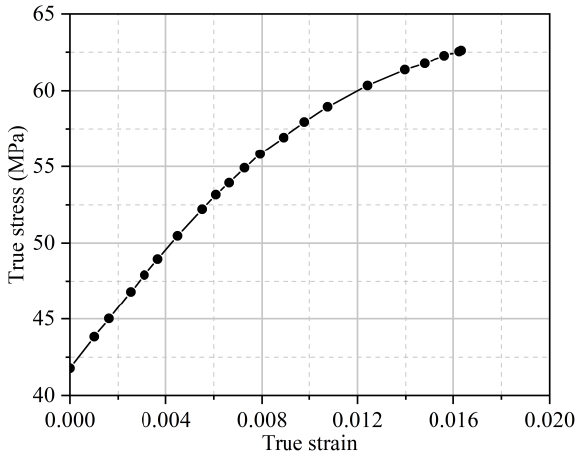
Figure 4. True stress versus true strain curve of FIPP material.